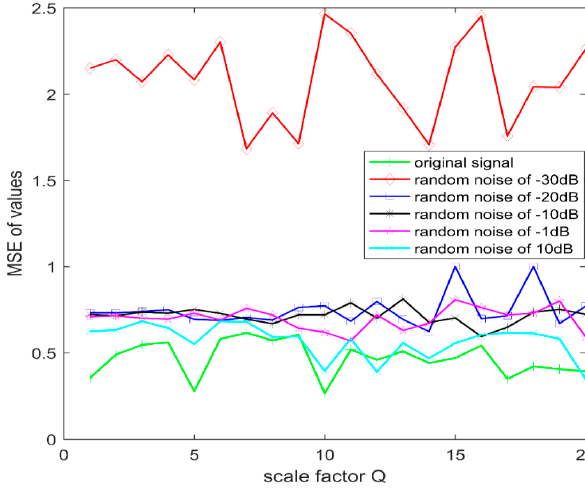
Figure 6. Scale factor